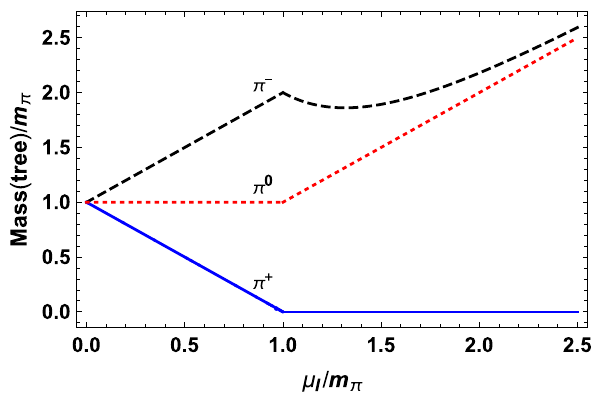
Fig. 3 Thenormalizedpressureasafunctionofthenormalizedisospin chemical potential. The tree-level and one-loop results are the red solid and blue dashed line, respectively, using m cen and f cen . The band is obtained by varying m and f in their respective ranges. The dashed line is the lattice results from Ref.